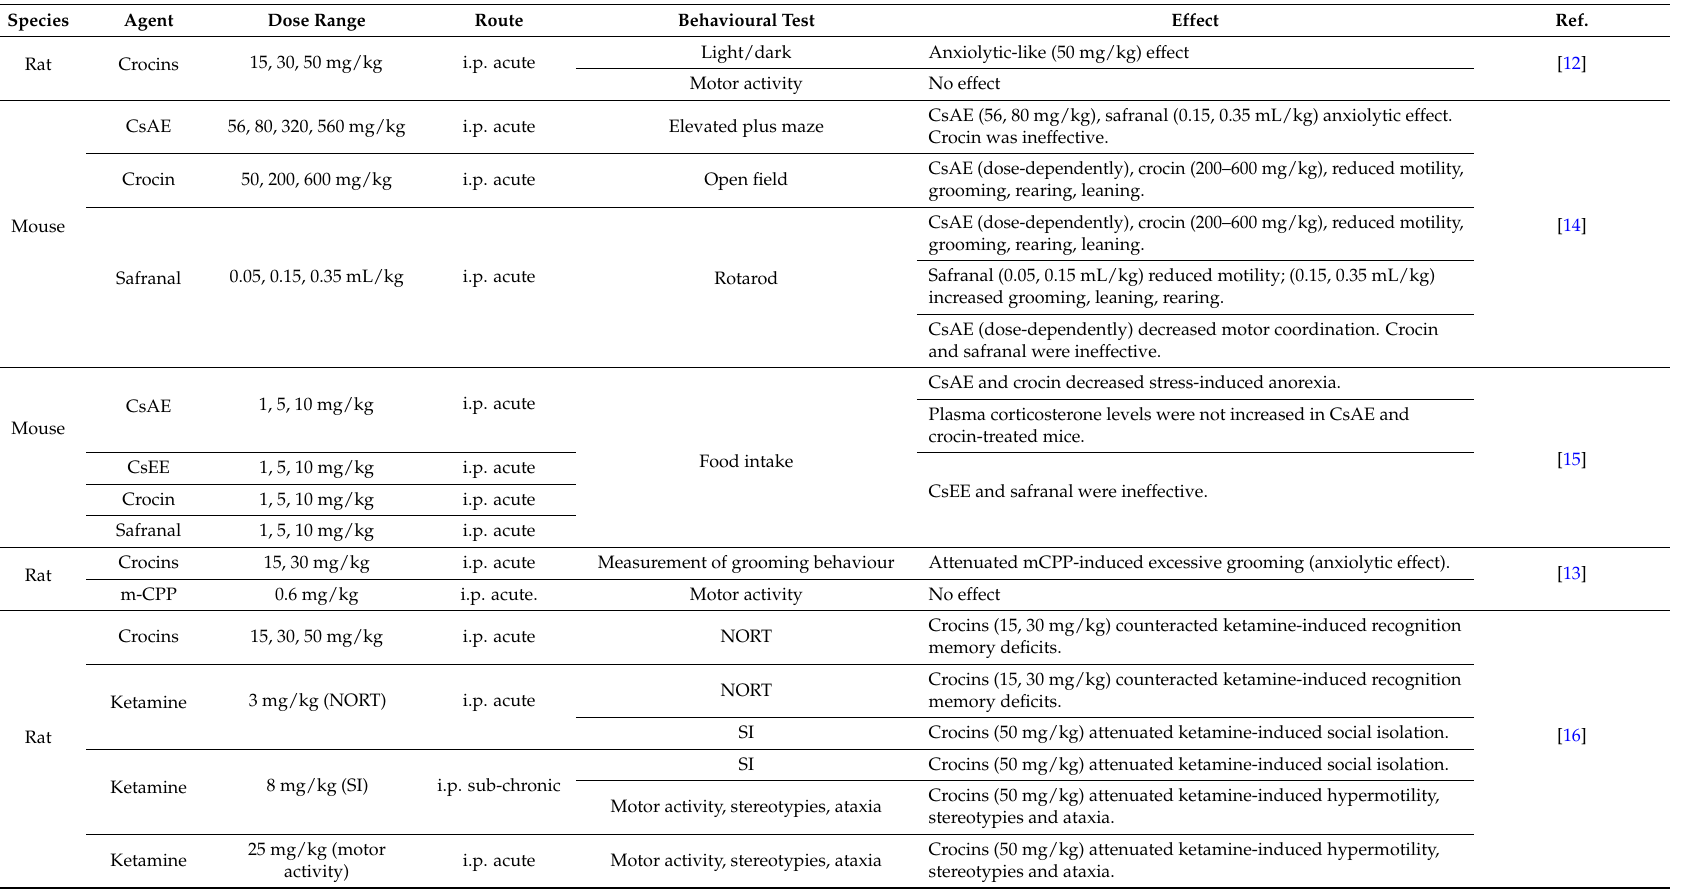
Table 1. Effects of Crocus sativus L., and its constituents on animal models of anxiety disorders and